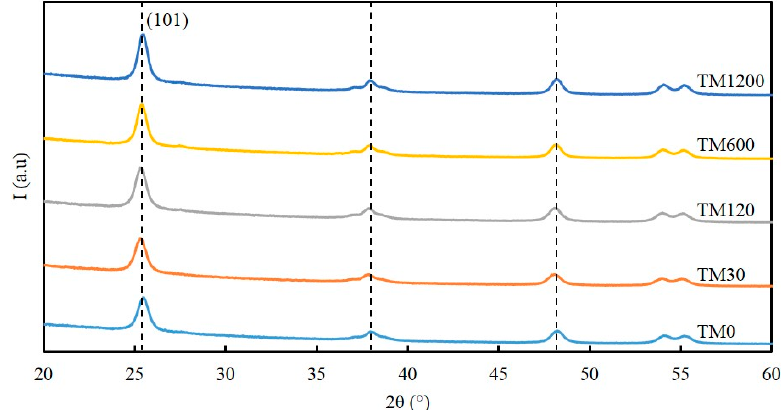
Figure 2. X-ray diffraction (XRD) patterns of titania samples calcined at 400 °C and exposed to different vacuum times.